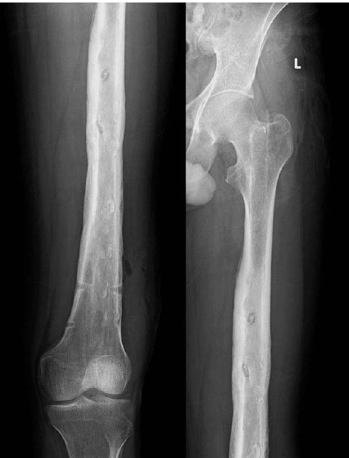
Figure 6. Complete removal of the broken distal segment of the